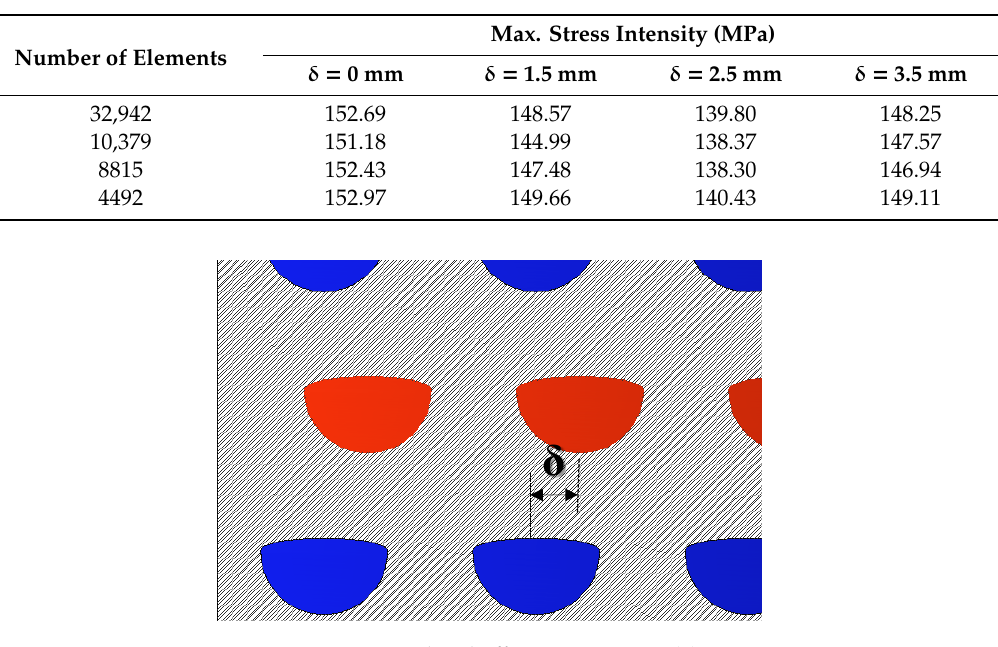
Figure 6. simulated offset arrangement ( δ ). Figure 6. Simulated o ff set arrangement ( δ Table 4. Maximum stress intensity on the different maximum mesh element sizes at the different additional elliptical channel radii (r 1 ).